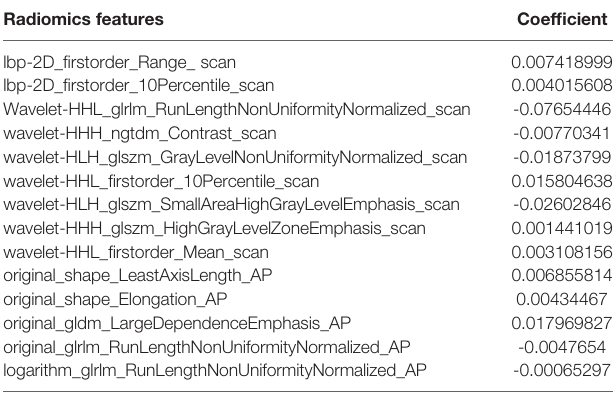
TABLE 2 | Radiomics features selected in ANOVA and LASSO regression analysis. Radiomics